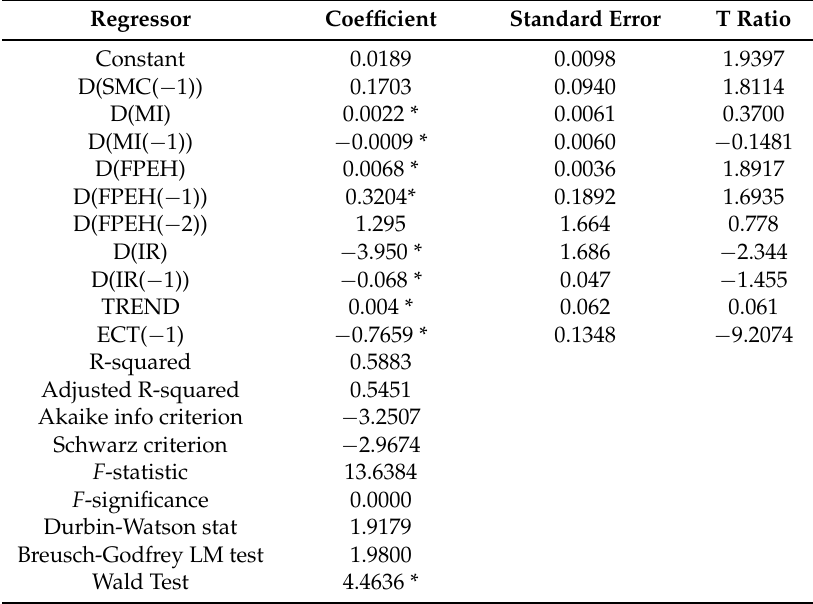
Table 7. Error correction representation for the selected ARDL model.